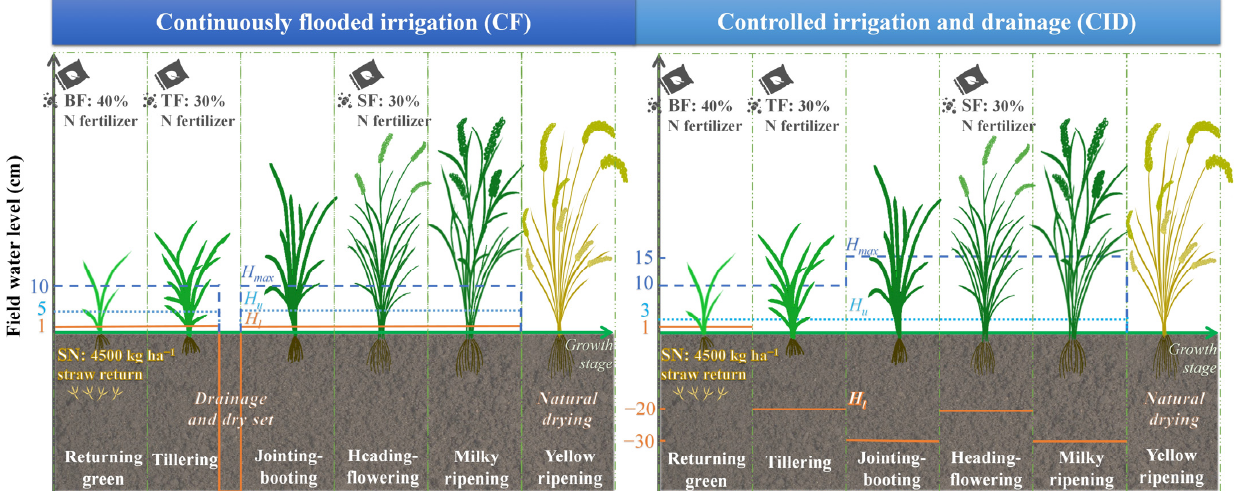
Figure 2. Schematic of fertilizer and water management for different treatments at various growth stages of rice. The soil surface is set as the zero point of the ordinate, so positive values indicate the ponding-water depth and negative values indicate the groundwater level. H max represents the maximum ponding-water depth after rainstorm events; H u represents the upper limit of irrigation; and H l represents the lower threshold of irrigation when the field water level drops to it, respectively. N300 represents the local farmers’ high fertilization level of 300 kg N ha − 1 without straw return, while SN225 and SN150 represent straw return with 25% N and 50% N reduction, at 225 and 150 kg N ha − 1 , respectively. BF, TF and SF denote the base, tillering, and spikelet-developing fertilizer, respectively.